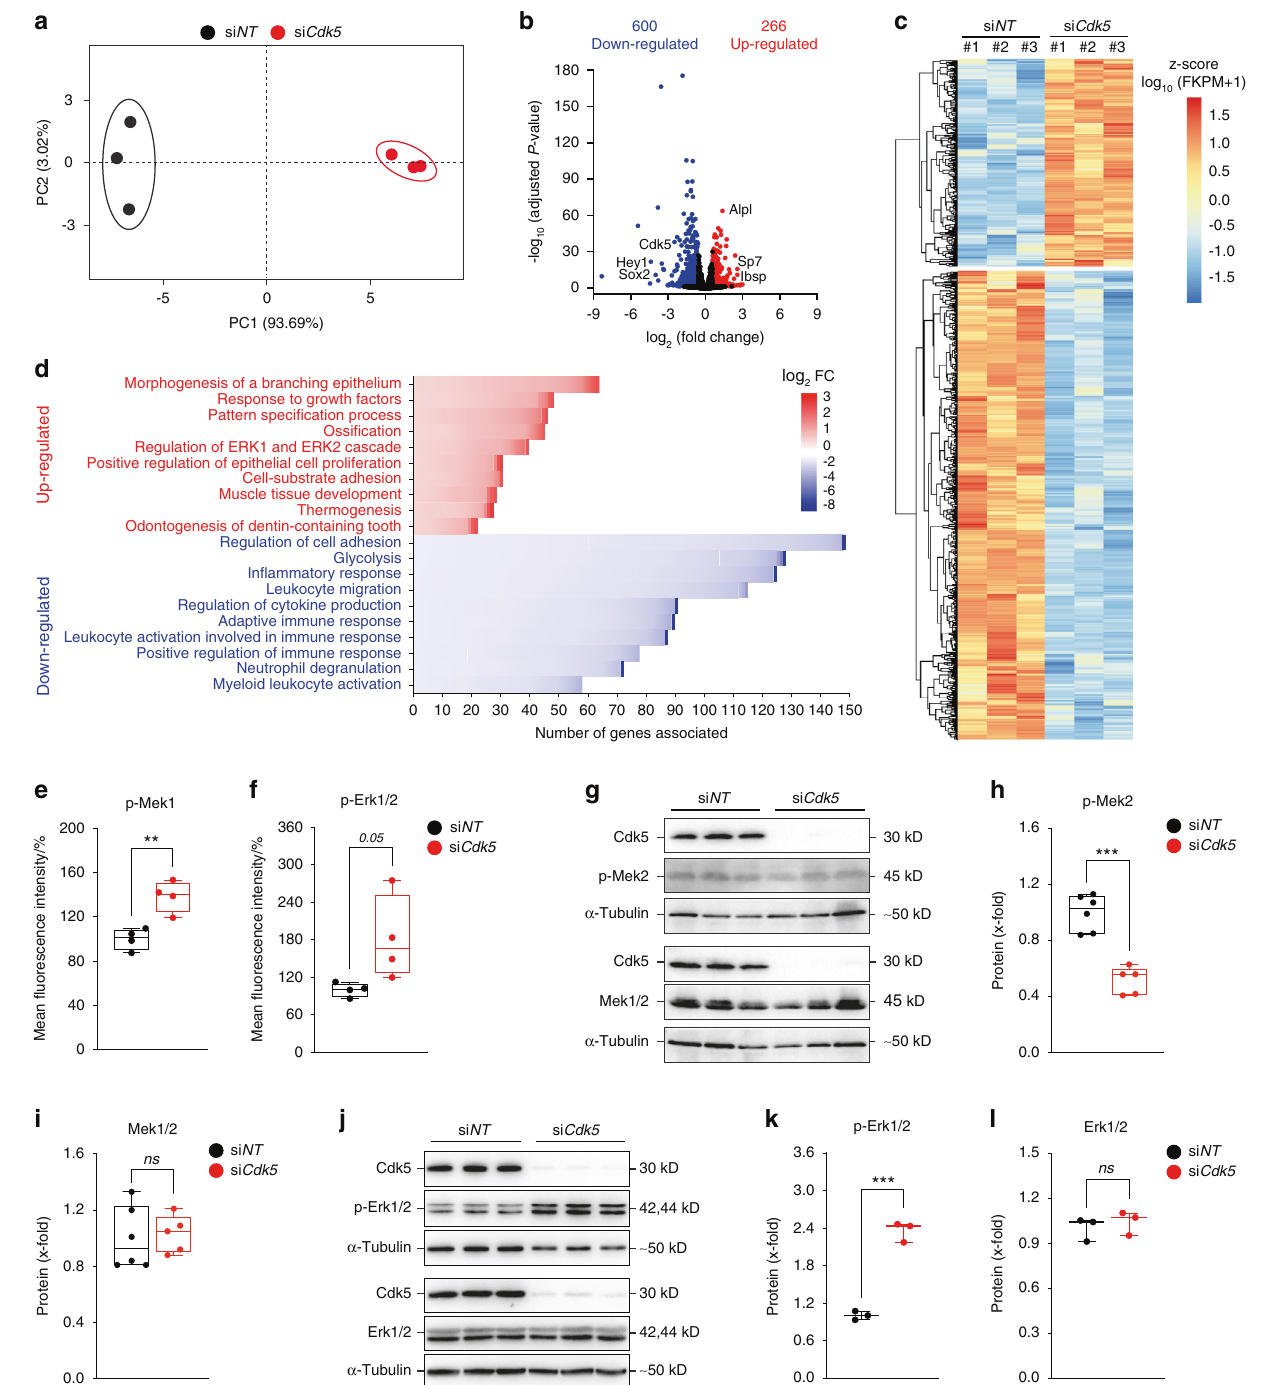
Fig. 5 Cdk5 suppresses osteoblast differentiation through inhibition of the Erk pathway. a Principal component analysis (PCA) of the RNA-seq data based on the gene transcription of six independent samples. Primary murine calvarial osteoblasts treated with si NT or si Cdk5 for 8 days were distinctly clustered within the fi rst principal component (PC1), explaining 93.69% of the observed variation. b Volcano plot: the red dots indicate genes with signi fi cantly upregulated expression (266), the blue dots indicate genes with signi fi cantly downregulated expression (600), and the black dots indicate non-signi fi cant differentially expressed genes (log 2 FC ≥ 0.58 and ≤ − 0.58 and FDR (adjusted p value)< 0.05). c Hierarchical clustering analysis of all differentially regulated genes from the primary murine calvarial osteoblasts transfected with si NT or si Cdk5 for 8 days. d Genes with differentially upregulated and downregulated expression were independently subjected to Metascape analysis. The number of genes in each of the top ten upregulated and downregulated enriched Gene Ontology terms present in our dataset and sorted on the basis of log 2 FC were plotted. Bio- Plex assays of the primary murine calvarial osteoblasts transfected with si NT or si Cdk5 for 8 days. Percentage fl uorescence intensity quanti fi cation of e p-Mek1 (Ser 217 /Ser 221 ) and f p-Erk1/2 (Thr 202 /Tyr 204 ). g Western blots of pMek2 (Thr 394 ) and Mek1/2 from the primary murine calvarial osteoblasts treated with si NT or si Cdk5 for 8 days. Protein quanti fi cation of h p-Mek2 (Thr 394 ) and i , Mek1/2. j , Western blots of pErk1/2 (Thr 202 /Tyr 204 ) and Erk1/2 from the primary murine calvarial osteoblasts treated with si NT or siCdk5 for 8 days. Protein quanti fi cation of k p-Erk1/2 (Thr 202 /Tyr 204 ) and l , Erk1/2. Data are represented as box-and-whisker plots with min. to max. as well as with superimposition of all of the data points. Statistical differences between groups were determined by unpaired homoscedastic two-tailed Student ’ s t test. * P <0.05, ** P <0.01, *** P